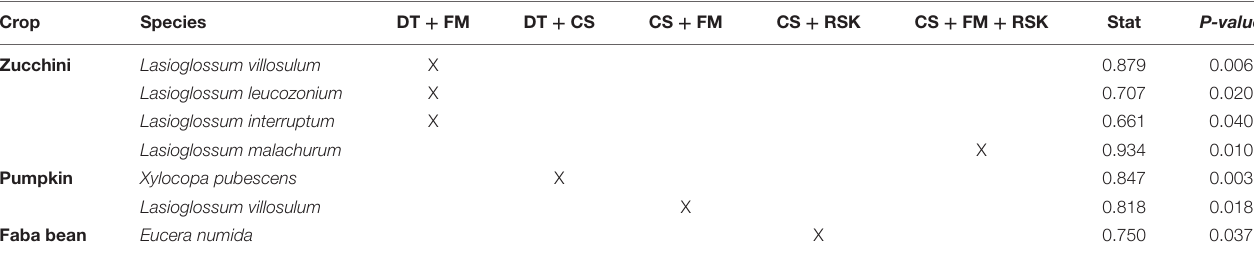
TABLE 2 | Indicator bee species visiting crops significantly associated with more than one region (DT, Draa-Tafilalet; FM, Fes-Mekenes; CS, Casablanca-Settat; RSK, Rabat-Sale-Kenitra).